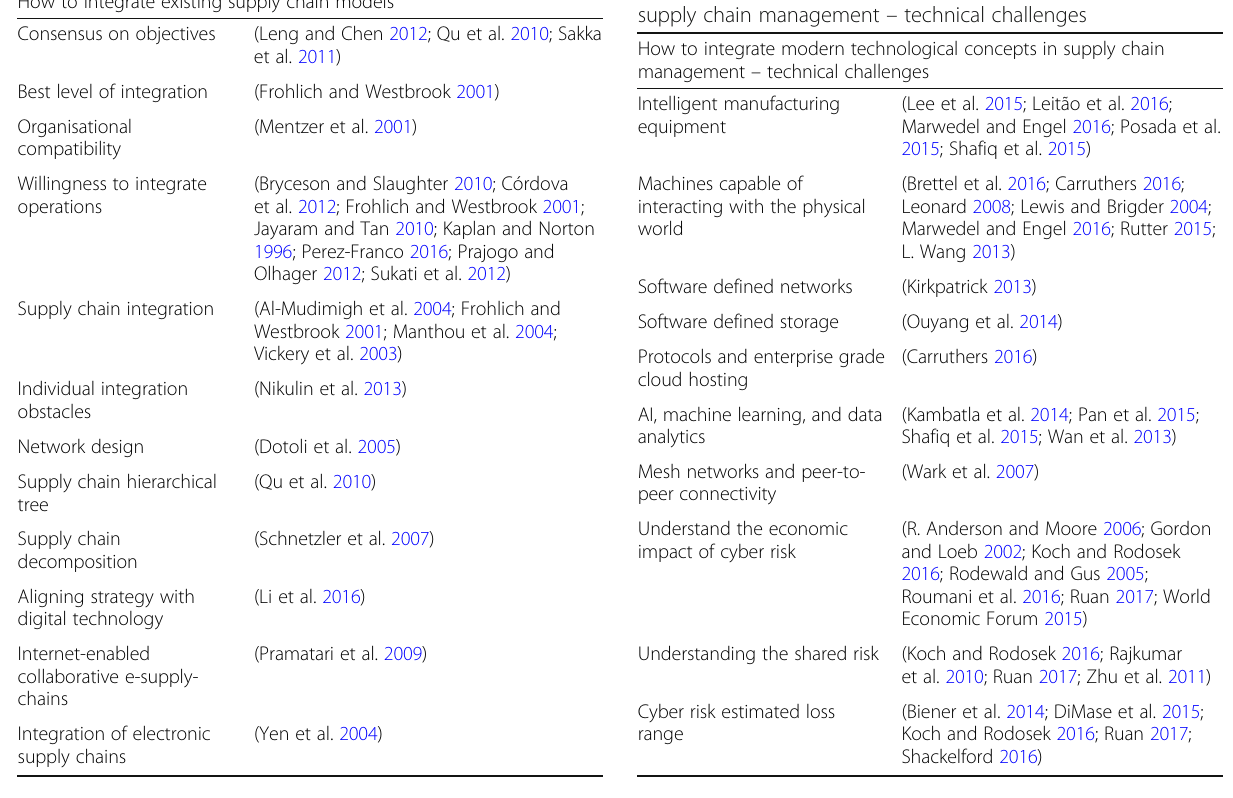
Table 2 How to integrate modern technological concepts in supply chain management – technical